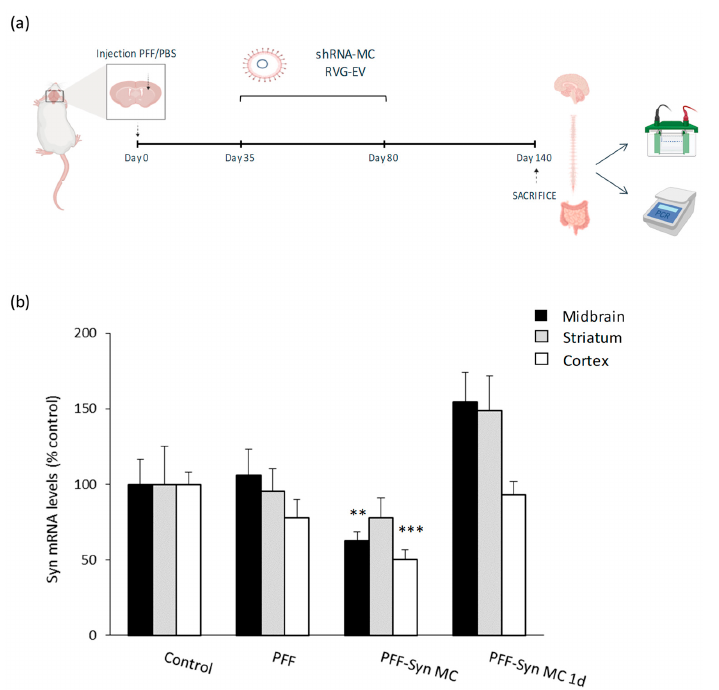
Figure 4. Effect of anti-alpha-synuclein shRNA-MC RVG-EV therapy administrated after the development of alpha-synuclein pathology. ( a ) Experimental design of the study is shown ( b ) Alpha-synuclein mRNA expression levels in the midbrain, striatum, and cortex of mice treated with the therapy after the development of pathology. Values are expressed as mean ± SEM ( n = 8). ** p < 0.01; *** p < 0.001, parametric one-way ANOVA test.